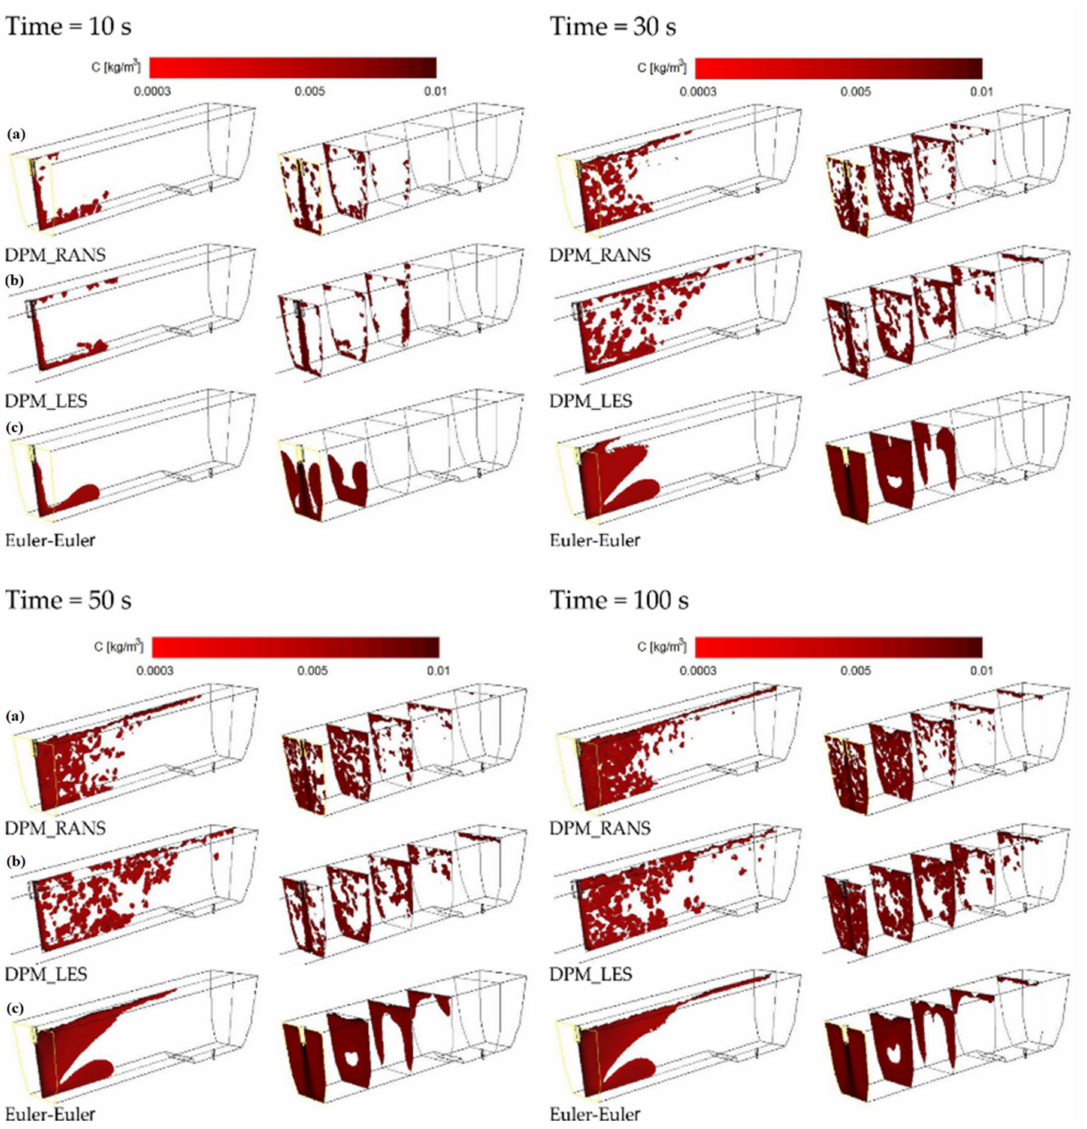
Figure 6. Contour maps of microparticles distribution (100 µ m) on the control planes: ( a ) DPM_RANS; ( b ) DPM_LES; ( c )